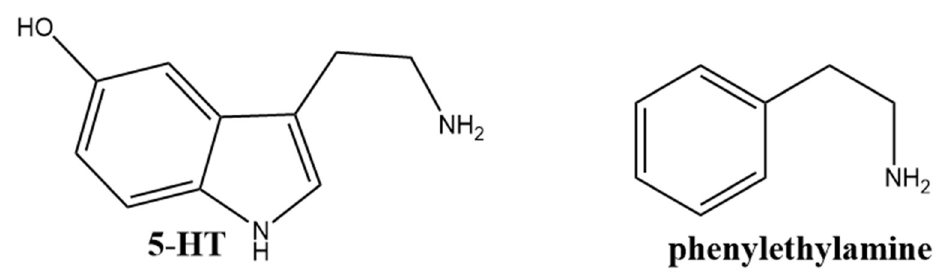
Figure 1. Chemical structures of 5-HT and phenethylamine.